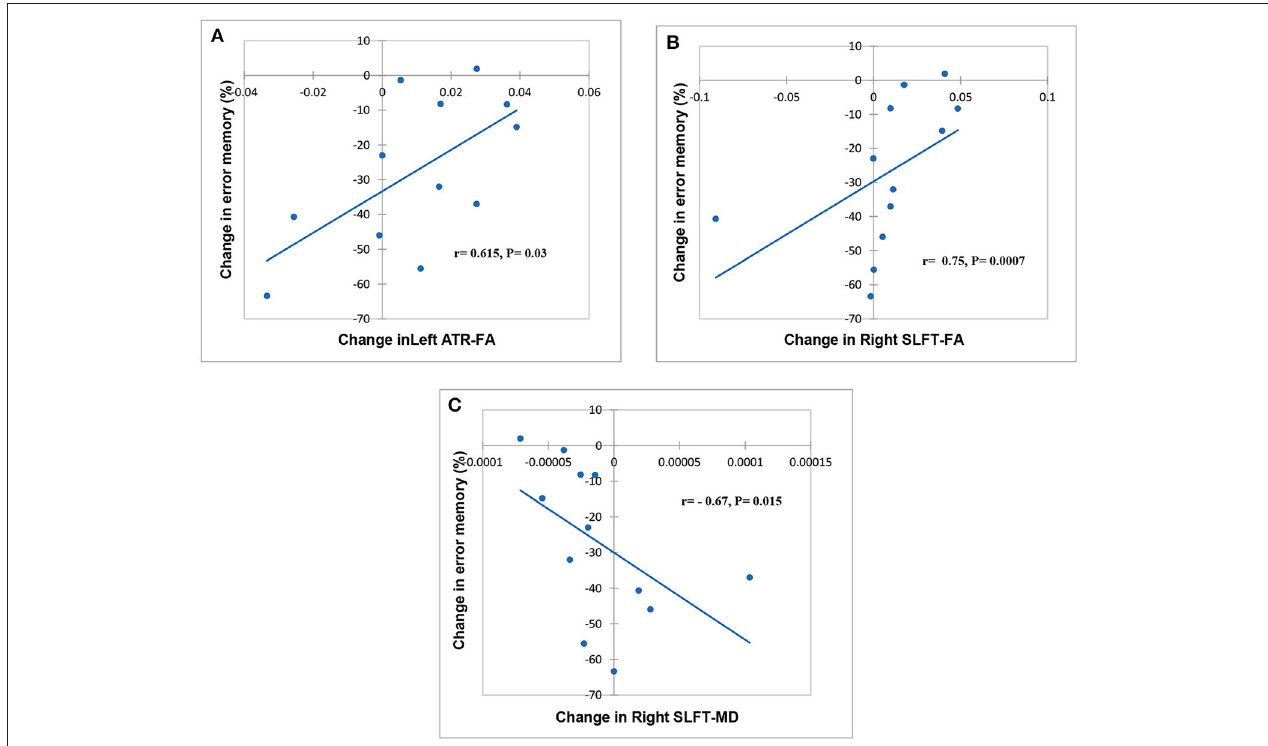
FIGURE 2 | Scatter plot showing a relationship between change related to baseline in FA, MD, and cognitive task. Significant relationships between FA in left ATR, FA, and MD in the right SLFt and % error memory indicating, respectively in (A–C) .